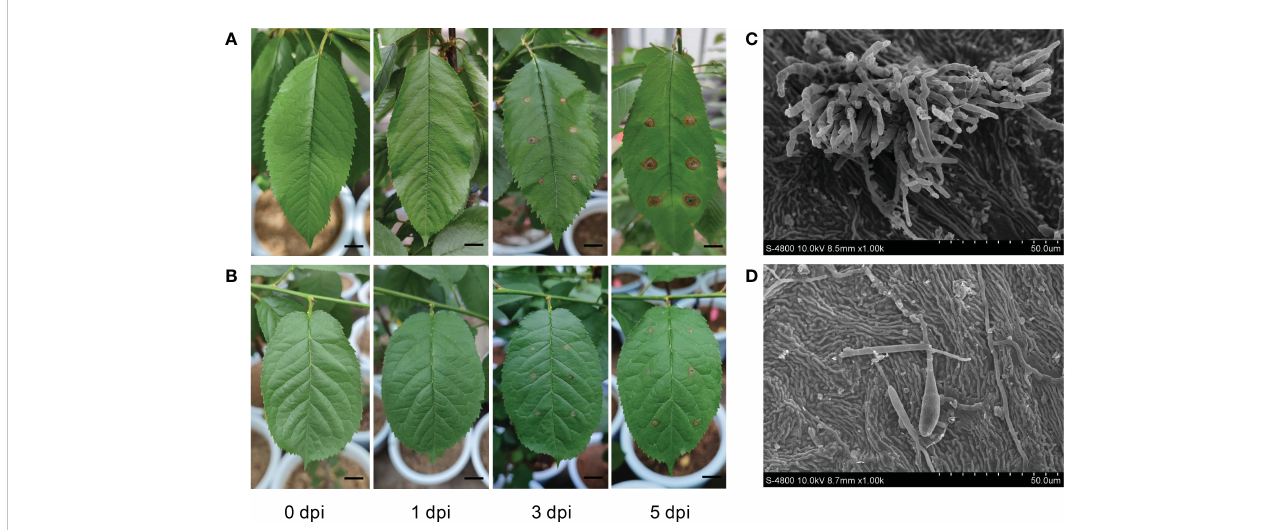
FIGURE 1 Analysis on symptoms and physiological indexes of Alternaria alternata infection in susceptible cultivar (SC) and resistant cultivar (RC). Disease symptoms of the (A) SC and (B) RC were observed following leaf inoculation with actively growing mycelia of A. alternata at 0, 1, 3, and 5 days post inoculation (dpi); scale bar = 10 mm. (C) Images showing infection in the SC at a magni fi cation of ×1.00 k at 5 dpi. (D) Images showing infection in the RC at a magni fi cation of ×1.00 k at 5